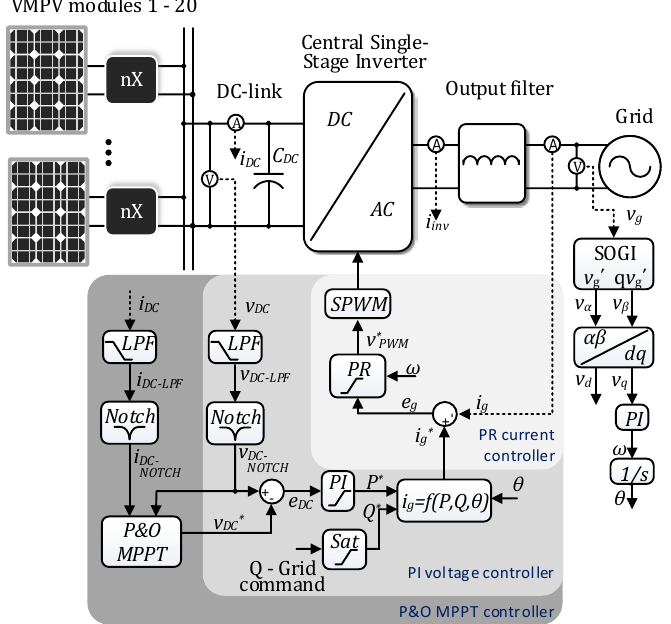
Figure 6. Complete control scheme of the proposed grid-connected PV system, consisting of three nested control loops.